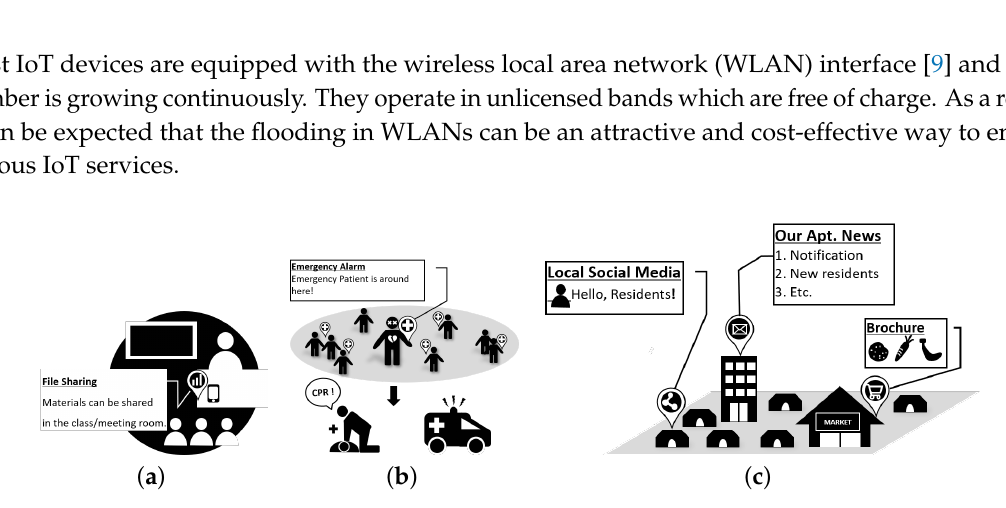
Figure 1. Examples of IoT services based on relayed broadcasting: ( a ) file sharing, ( b ) an emergency alarm, and ( c ) local social media or